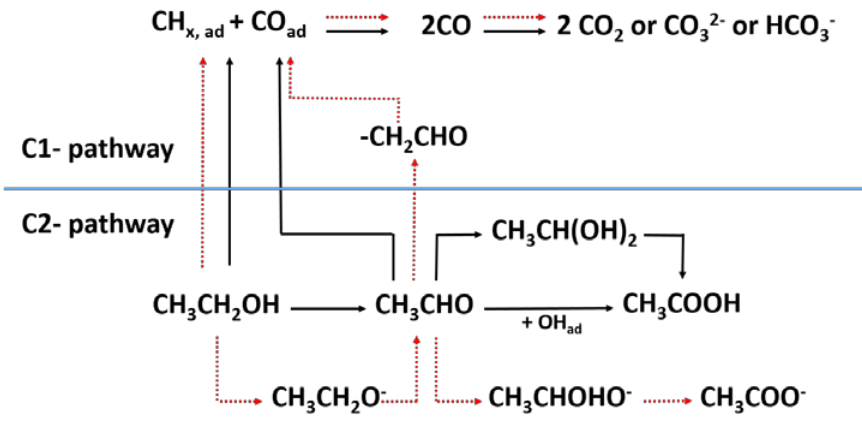
Figure 2. Proposed reaction mechanism for electro-oxidation of ethanol on Pt electrodes. Solid arrows denote the mechanism at low electrolyte pH, while dashed arrows denote the mechanism at high electrolyte pH. Adapted from Reference